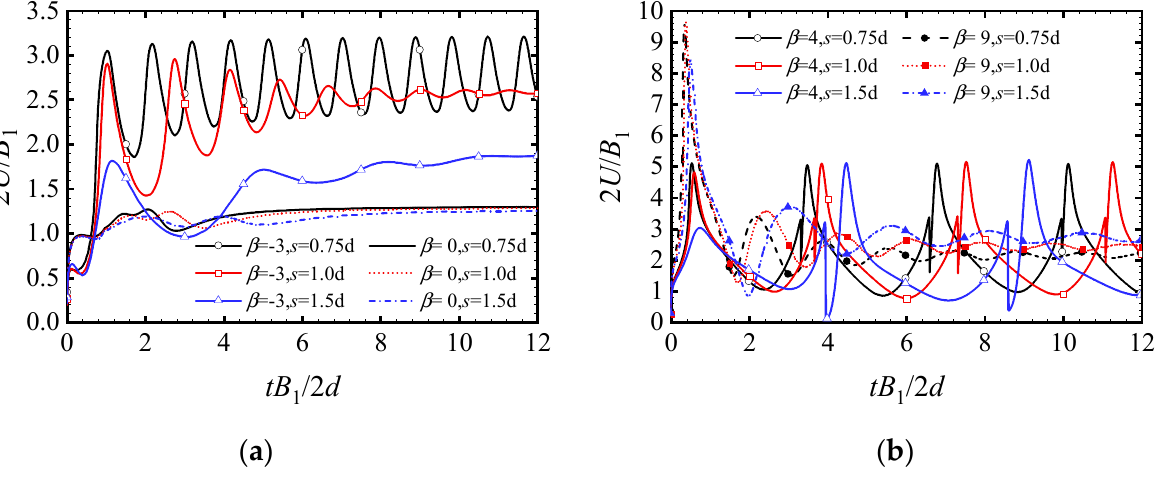
Figure 14. Change in the velocity of rod-shaped squirmers with different values of s ( Re s = 0.5, i = 2): ( a ) β = − 3 and β = 0; ( b ) β = 4 and β = 7.